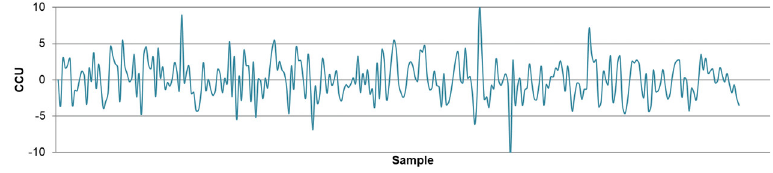
Figure A29. Prediction error of NN1 model testing dataset.